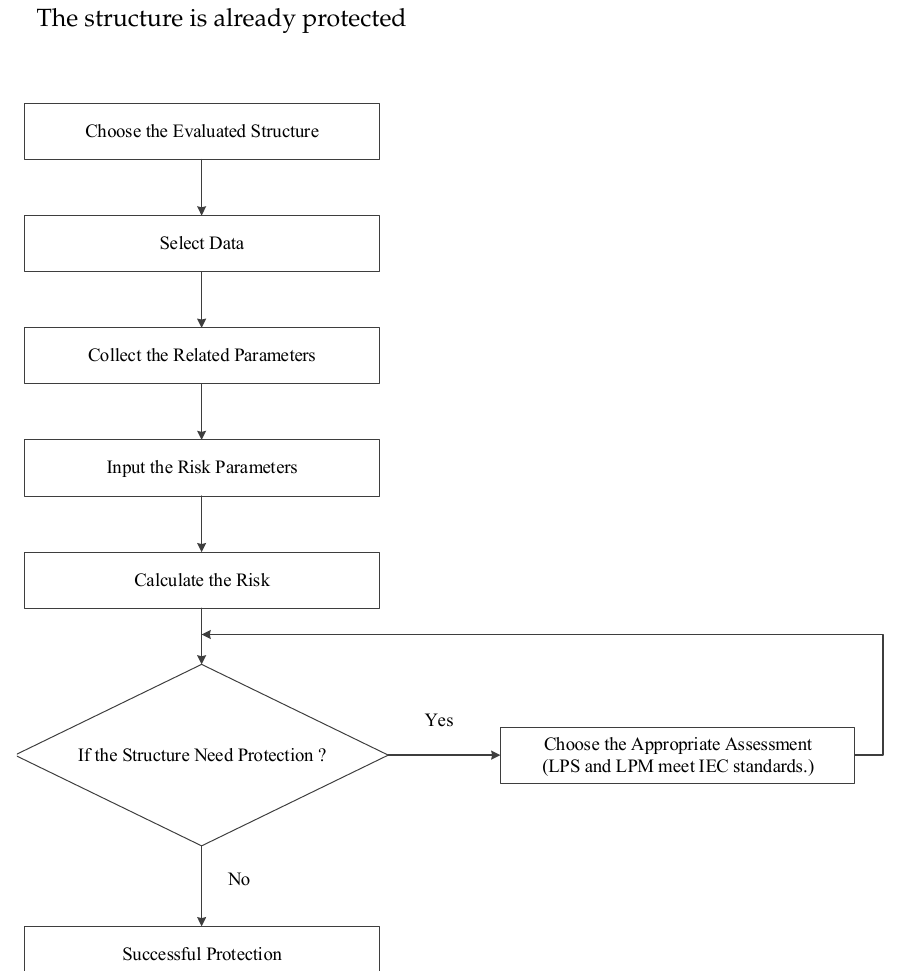
Figure 2. The flow diagram of design process of the lightning risk.